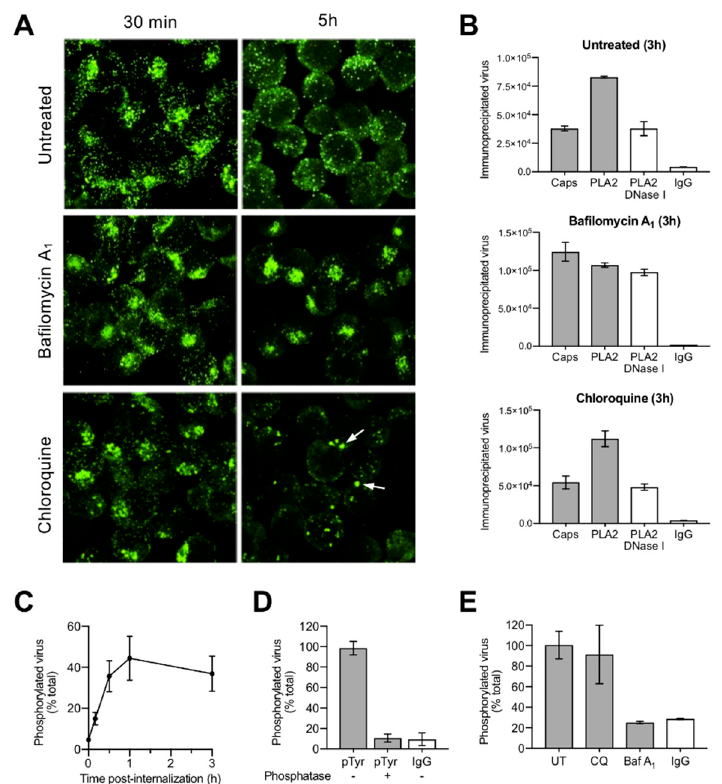
Figure 5. Conformational epitope rearrangement, DNA externalization and phosphorylation occur after endosomal escape. ( A ) E ff ect of BafA 1 and CQ on endosomal escape and conformational epitope integrity. Immunofluorescence images of infected cells treated or not with BafA 1 (20 nM) and CQ (25 µ M). The integrity of the conformational epitope and the characteristic endocytic clustering of the virus was examined by staining with the conformational antibody (Caps) at 30 min and 3 h pi. Arrows indicate the presence of enlarged endosomes in cells treated with CQ. ( B ) E ff ect of BafA 1 and CQ on the conformational rearrangement and nuclease sensitivity of the incoming virions. The virions were immunoprecipitated from infected cells at 3 h pi and quantified by qPCR, values correspond to geq / µ L. ( C ) Kinetics of B19V phosphorylation. At increasing times pi, virions were immunoprecipitated from cytoplasmic fractions with PLA2 (total virions) or with an antibody against phosphotyrosine and quantified by qPCR. ( D ) Phosphatase treatment abrogated the reactivity with the phosphospecific antibody. Before immunoprecipitation, the intracellular capsids were treated or not with lambda phosphatase (500 U) for 1 h at 30 ◦ C. ( E ) E ff ect of BafA 1 (20 nM) or CQ (25 µ M) on B19V phosphorylation. Virions from cytoplasmic fractions were immunoprecipitated with the phosphotyrosine antibody at 3h pi and quantified by qPCR. As control, an unrelated IgG was